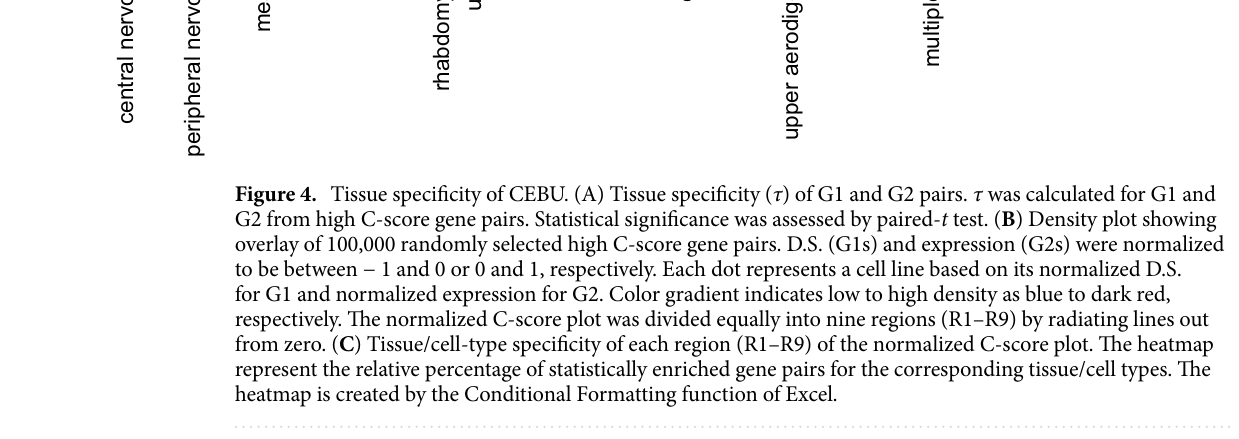
G1 quantile normalized D.S.